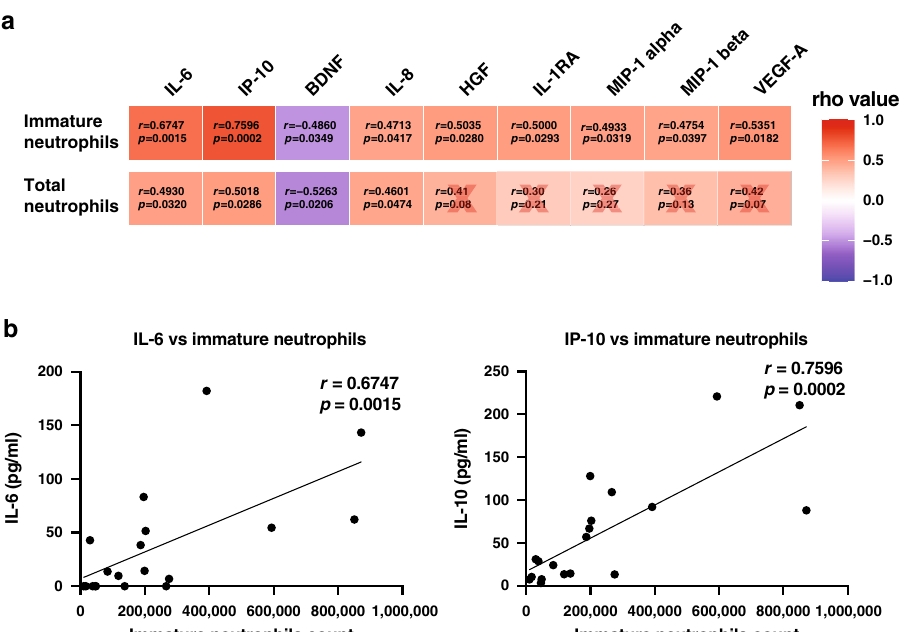
Fig. 4 Immature neutrophils correlate with several analytes in paired patient plasma. a Spearman correlations between total neutrophils or immature neutrophils and plasma analytes. Red cross represents non-signi fi cant correlations. b Individual plots of Spearman correlations between immature neutrophil counts and IL-6 and IP-10. Line was drawn using simple linear regression. Data was analysed using non-parametric Spearman correlation two- tailed function in Prism. Data from n = 19 individual acute COVID-19 patients. Data available in source data fi plasma collection, “ A Multi-centred Prospective Study to Detect Novel Pathogens and Characterize Emerging Infections (The PROTECT study group) ” , a domain speci fi c review board (DSRB) evaluated the study design and protocol, which was approved under study number 2012/00917 the National Healthcare Group (NHG). Healthy volunteers samples were obtained under the following IRB “ Study of blood cell subsets and their products in models of infection, in fl ammation and immune regulation ” under the number 2017/2806 by the SingHealth Centralised Institu- tional Review Board (CIRB). Donor information . Patients who tested PCR-positive for SARS-CoV-2 in a respiratory sample from February to April 2020 were recruited into the study 72 .